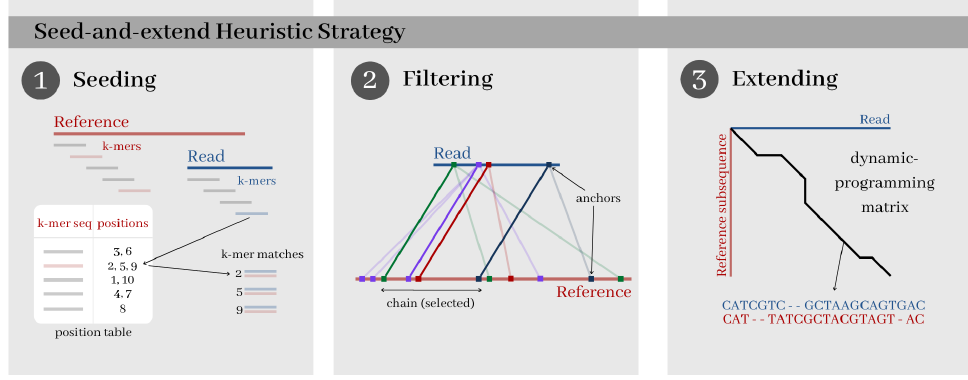
Figure 1. The seed-and-extend reference-guided read assembly strategy. This is a simplified example of the steps adopted in Minimap2 [14]. (1) The seeding stage implements a position table indexing method for each unique sequence of a length k (k-mer) in the reference; this allows for efficient computation of the exact matches of k-mers between the read and reference, defining the anchors along them. (2) The filtering stage is performed via the chaining algorithm, which selects correlated anchors to form chains that are sorted by their corresponding scores. (3) In the extending stage, read sub-sequences are aligned to reference sub-sequences, guided by the anchoring positions in the selected